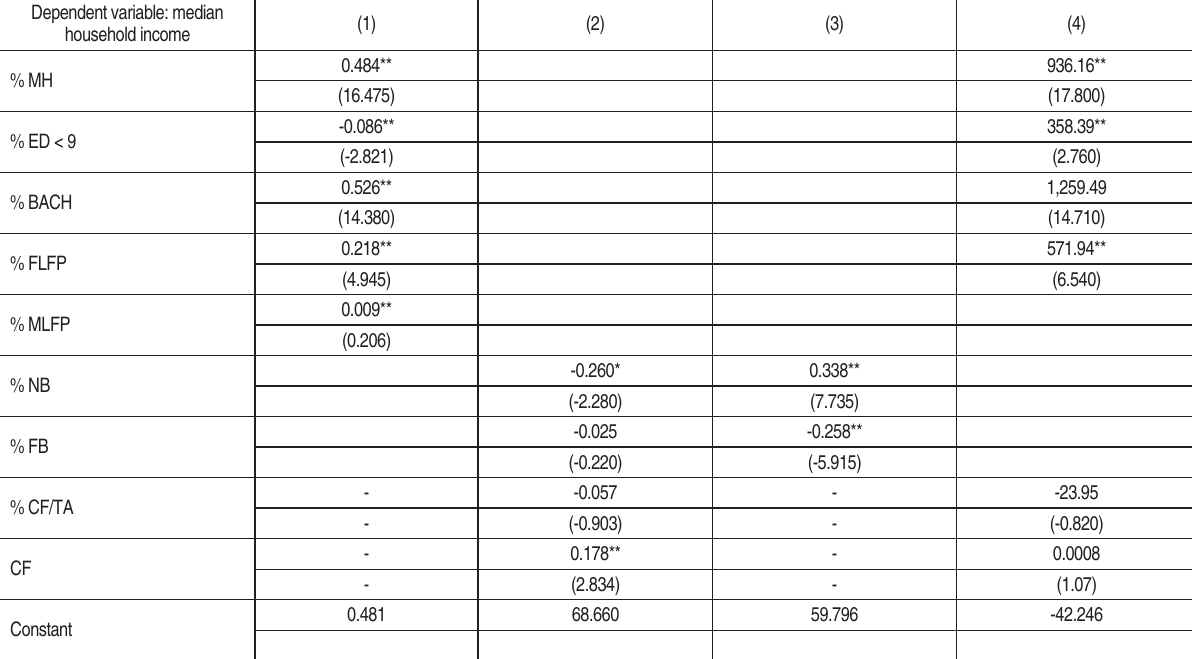
Table 1. Influences on median family